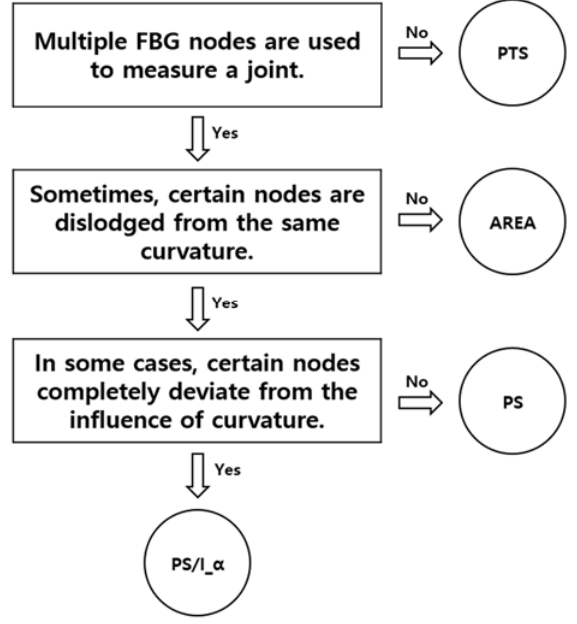
Figure 7. Flow chart diagram for selecting algorithms for measuring finger joint angles with FBG strain sensors.